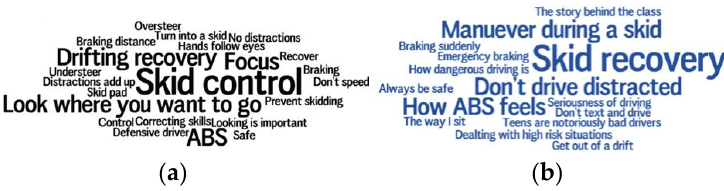
Figure 8. Word cloud of the most important thing learned: survey ( a ) and interview ( b ).